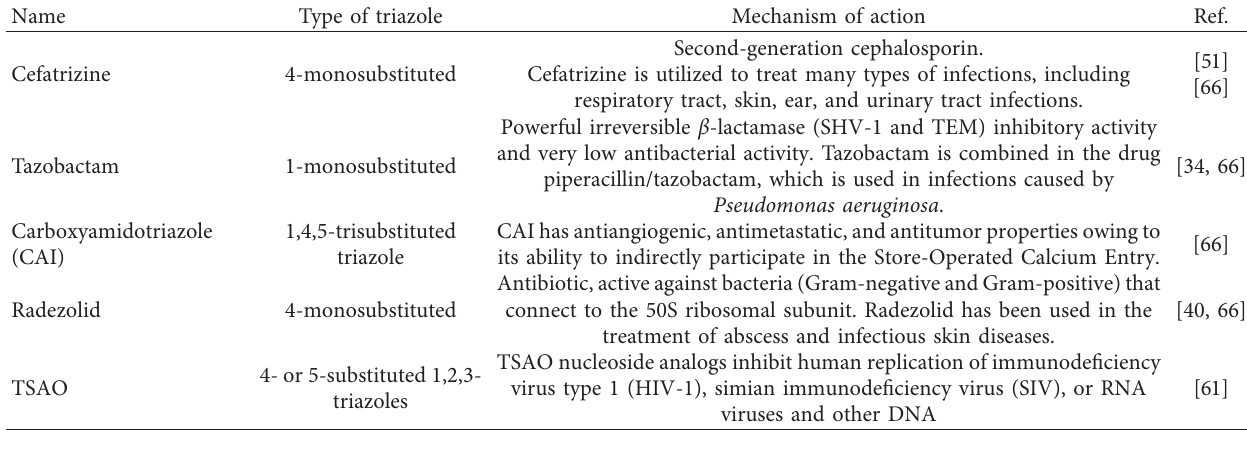
Table 1: Mechanism of action of 1,2,3-triazole-based marketed drugs.